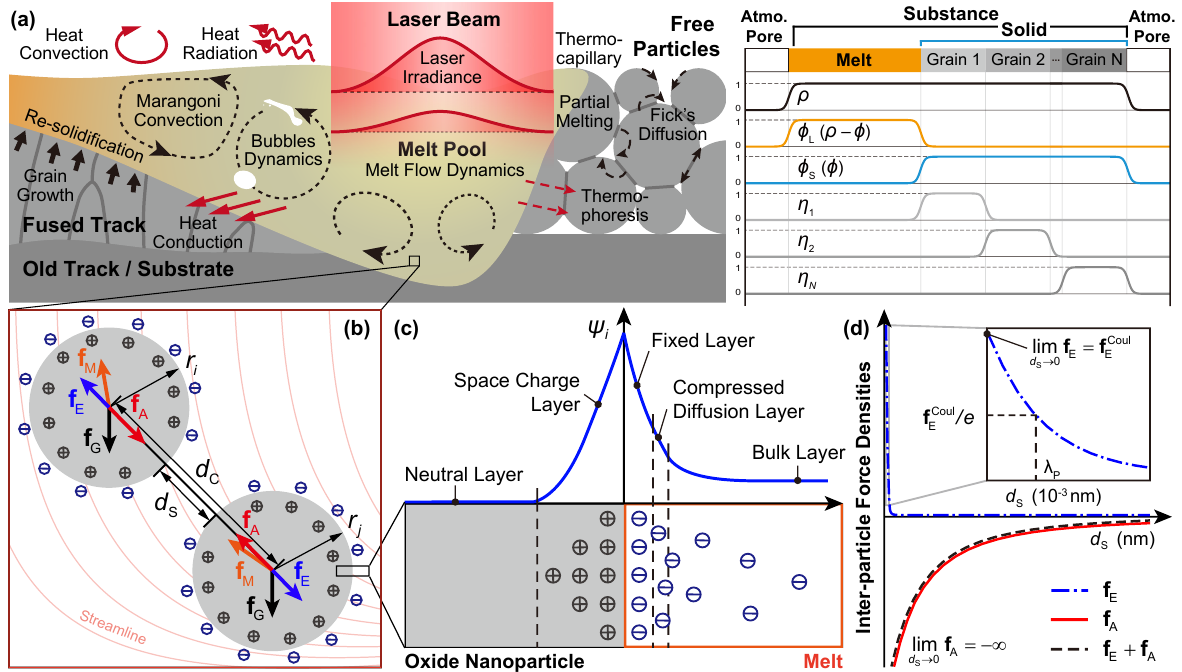
Figure 1. ( a ) Schematic of interactive physical phenomena during a stable LPBF process (left) and the order parameter profiles of the phase-field model (right); ( b ) force analysis of two oxide nanoparticles (labeled as i and j ) in the melt pool with streamline and charges denoted; ( c ) schematic of charge distribution and potential profile across the oxide-melt interface based on explanations in [49]; ( d ) variation of the inter-particle force densities to the surface